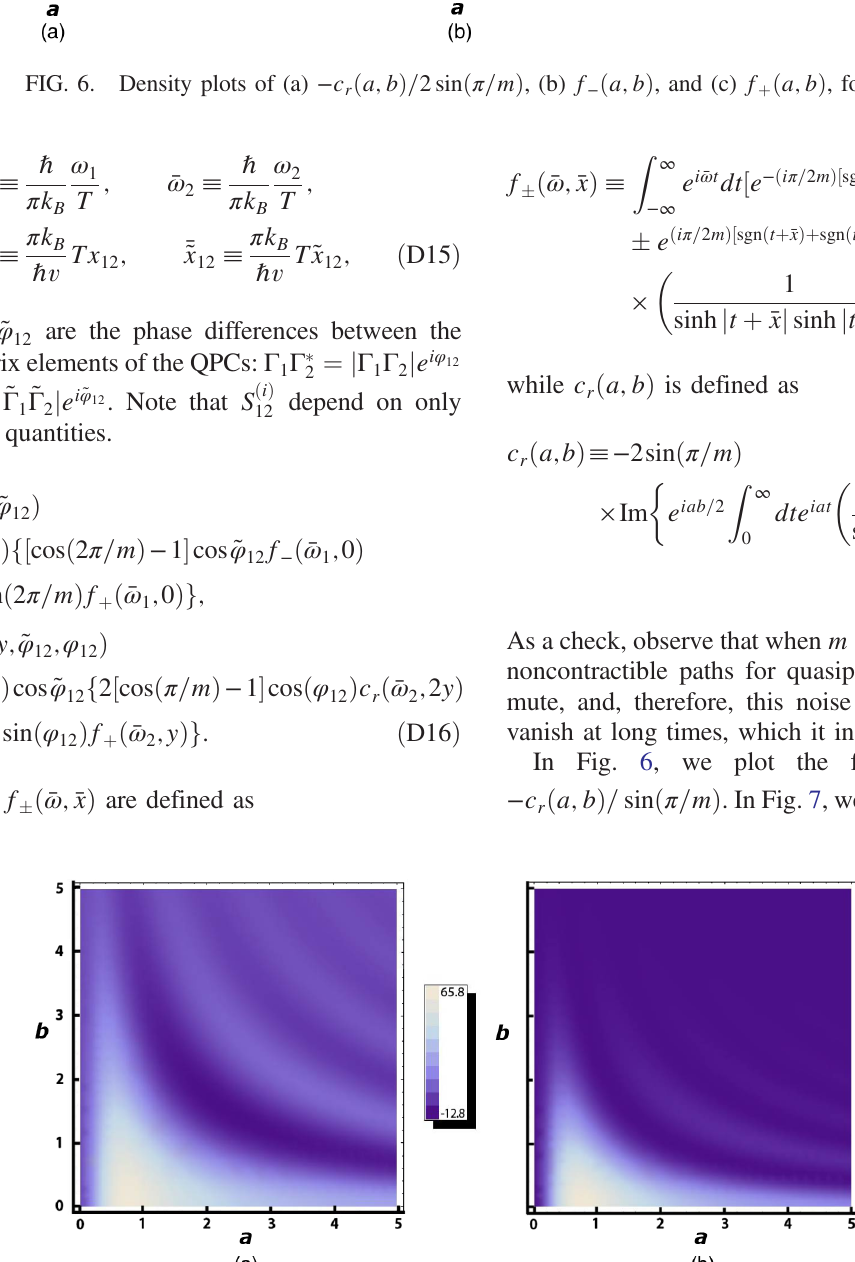
FIG. 7. Density plots of (a) S ð maximum for a and b of order 1, and decay to zero with increasing a and b